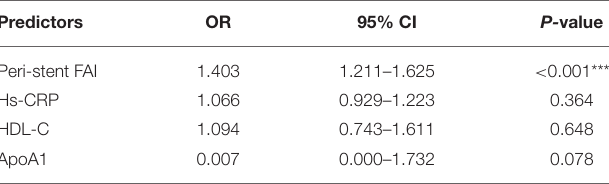
TABLE 5 | Comparison of the parameter in three major coronary artery